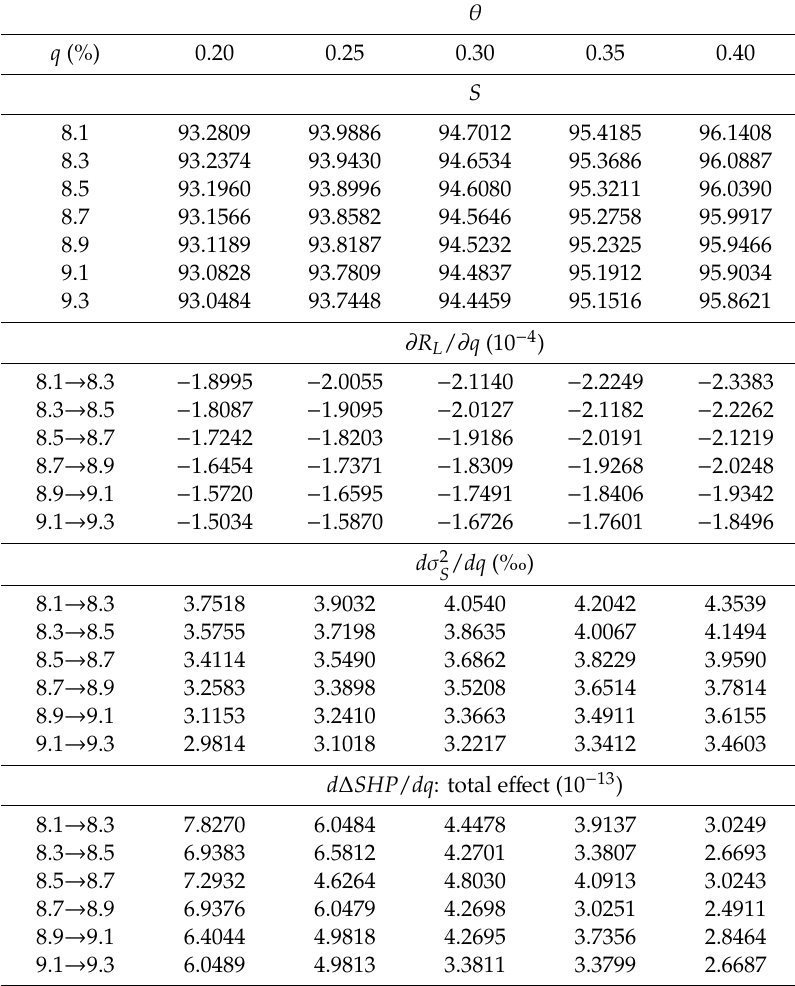
Table 8. E ff ects of capital-to-deposits ratio on diversification e ffi ciency at various levels of government capital injection.